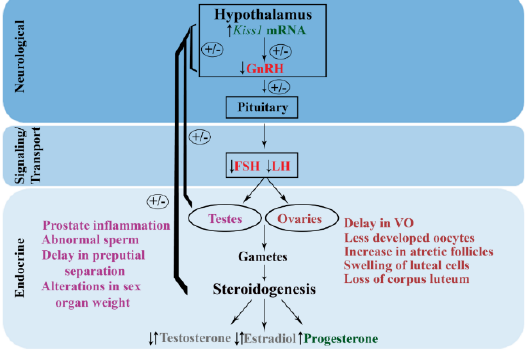
Figure 2. Working conceptual model of atrazine toxicity on the hypothalamus-pituitary- gonadal (HPG) axis across mammalian, anuran, and fish species. This diagram summarizes the main common alterations observed with atrazine exposure on the HPG axis based upon studies across multiple species and exposure paradigms. Atrazine exposure elicits an increase in Kiss1 mRNA and a decrease in gonadotropin releasing hormone (GnRH) release leading to a downstream reduction in luteinizing hormone (LH) and follicle stimulating hormone (FSH) from the anterior pituitary. This reduction in gonadotropins elicits alterations in testosterone, estrogen, and progesterone. In addition, histological and morphological alterations in the ovaries and testes are observed and are ultimately dependent on time of exposure and dose. (Green indicates increases, pink indicates reductions, and grey indicates that both increases and reductions are reported. Histological and morphological effects in males are indicated in purple, while alterations in females are in red; VO: vaginal